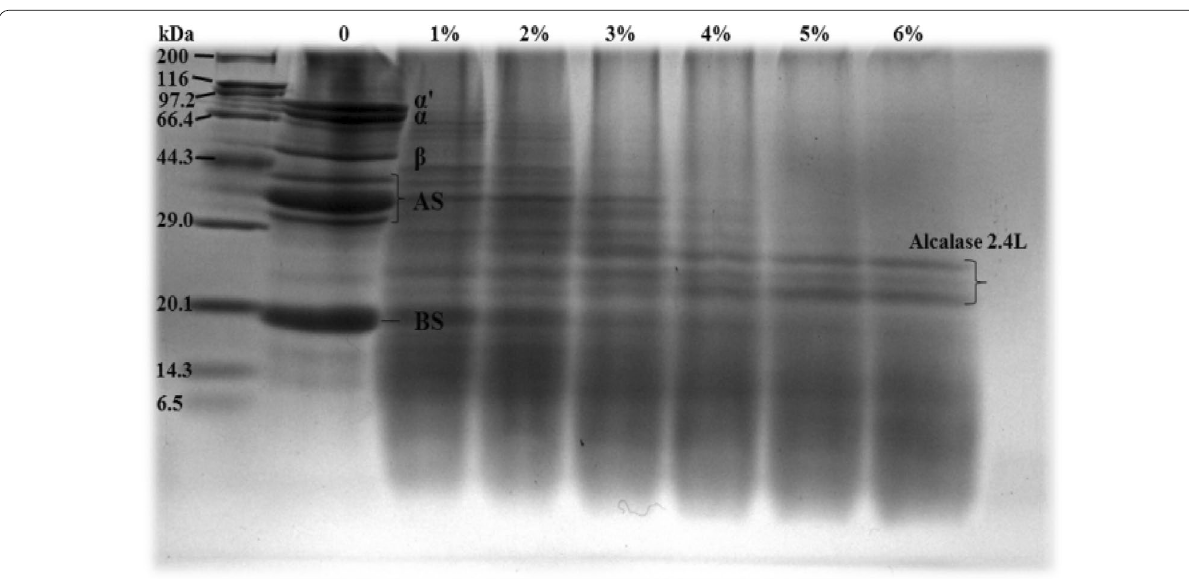
Fig. 1 The representative SDS-PAGE patterns of hydrolysates subjected to alcalase at DH of 0–6%, respectively. BS basic subunits; AS acidic subunits. α, α ′ and β are subunits from